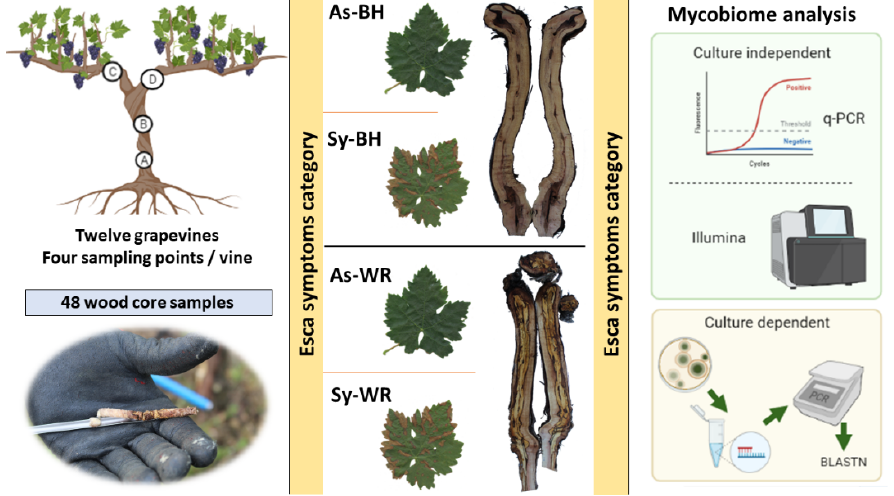
Figure 1. Graphic schedule of the material and methods used in the present